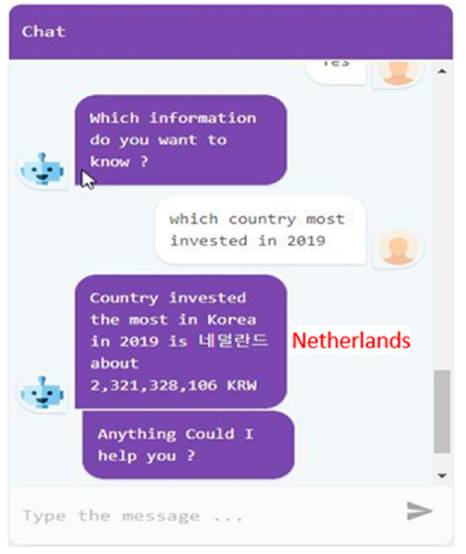
Figure 29. Assistant Systems providing information about the country investing the most in Korea.